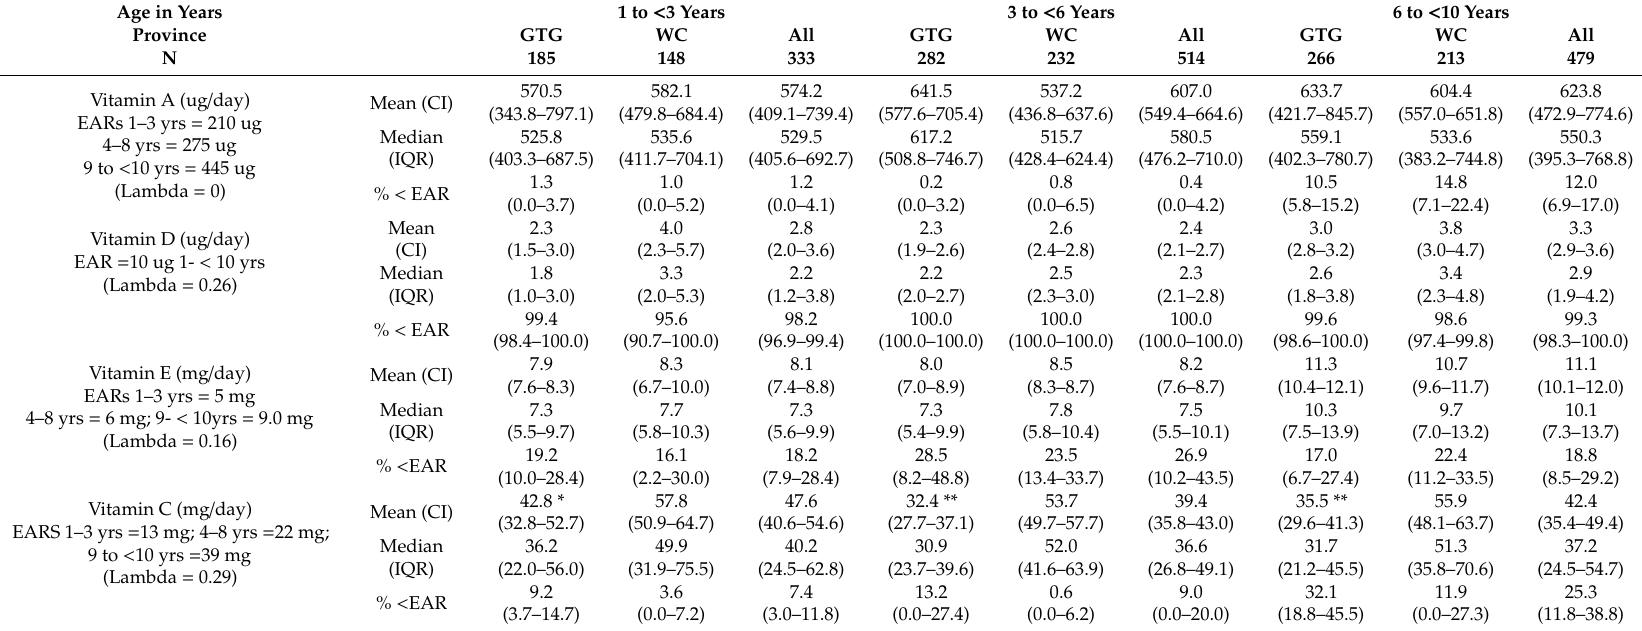
Table 3. Mean (CI), median (IQR) and percentage intake below the EAR for vitamins A, D, E and C (adjusted) of children aged 1 to < 10-years by province and